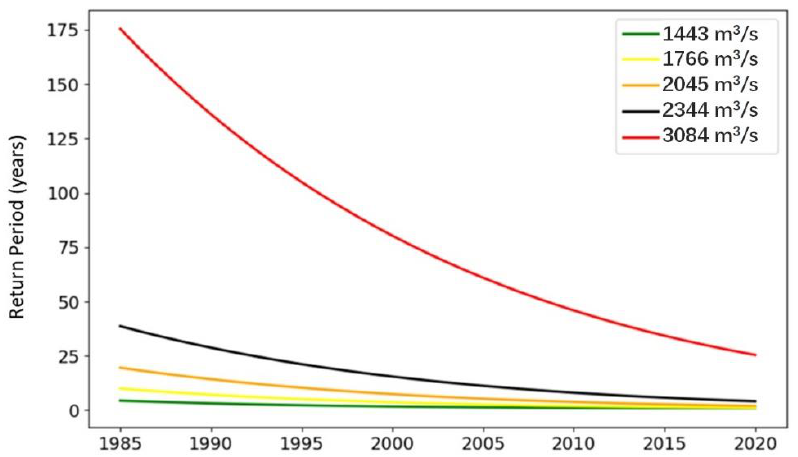
Figure 10. Evolution of return period associated to the flows of actual hazard-thresholds in the Niamey City.